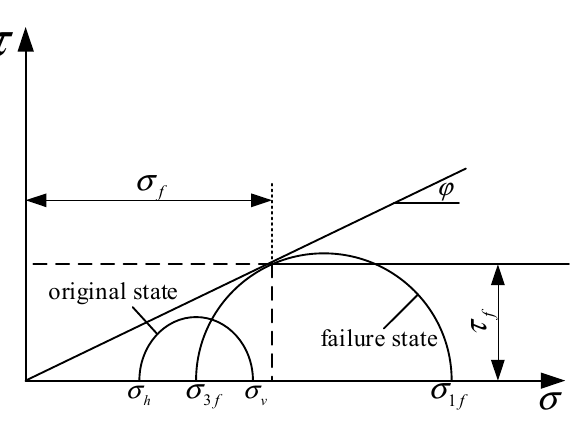
Figure 1. Soil failure criteria.